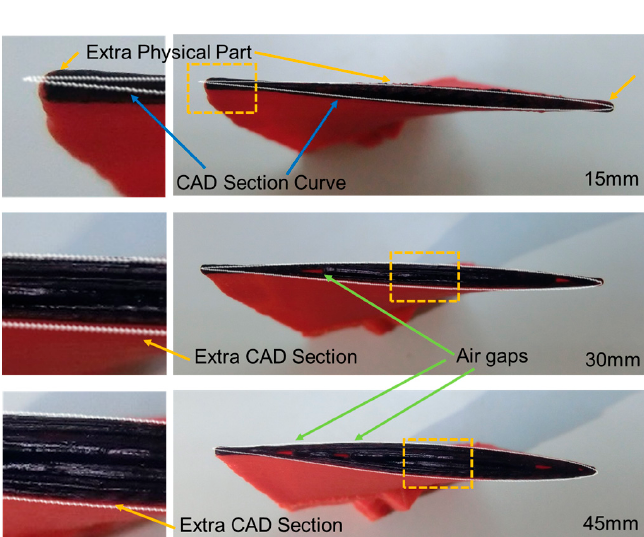
Figure 8. Physical cross-sectional models and super-imposed CAD cross-sectional curves .